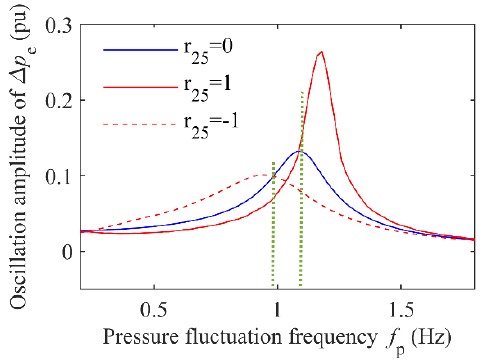
Figure 5. Amplitude change with f p in different r 25 s